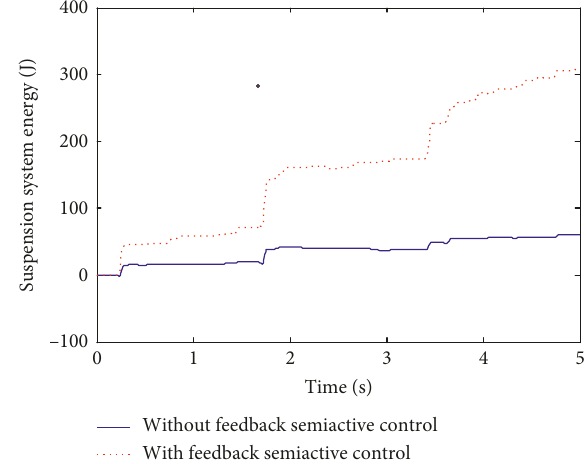
Figure 17: The system energy of the hybrid suspension in semi- active